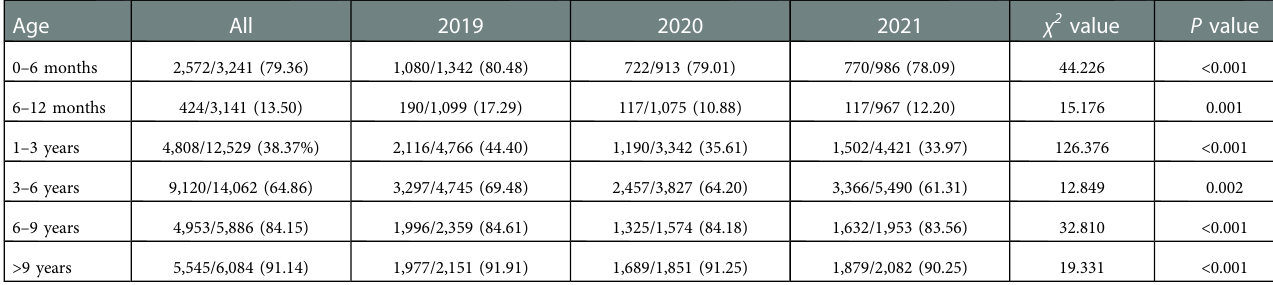
TABLE 3 The overall positive rate of EBV antibody patterns based on age between January 2019 and December 2021.